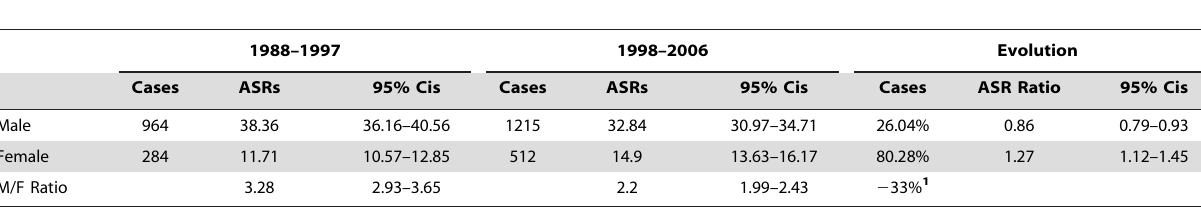
1 Male to female (M/F) ratio evolution